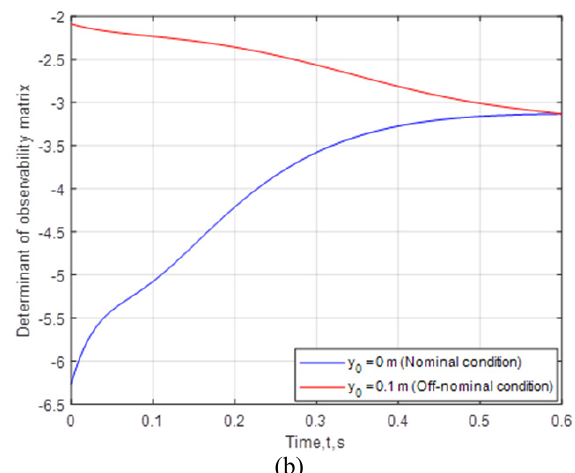
Figure 5. Controllability and observability computations for nominal (y 0 = 0 m) and off-nominal (y0 = 0.1 m) condi– tions, respectively; (a) determinant of controllability matri– ces vs. time; (b) determinant of observability matrices vs.